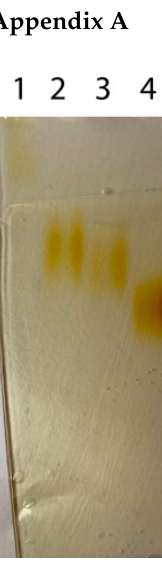
Figure A2. Simulated PXRD pattern of the sod ‐ ZIF ‐ 8 and experimental PXRD patterns of HRP@ZIF ‐ 8 samples obtained during different reaction times. Figure A3. SEM images of bulk samples of four types of biocomposites (scale bar = 1 μ m).